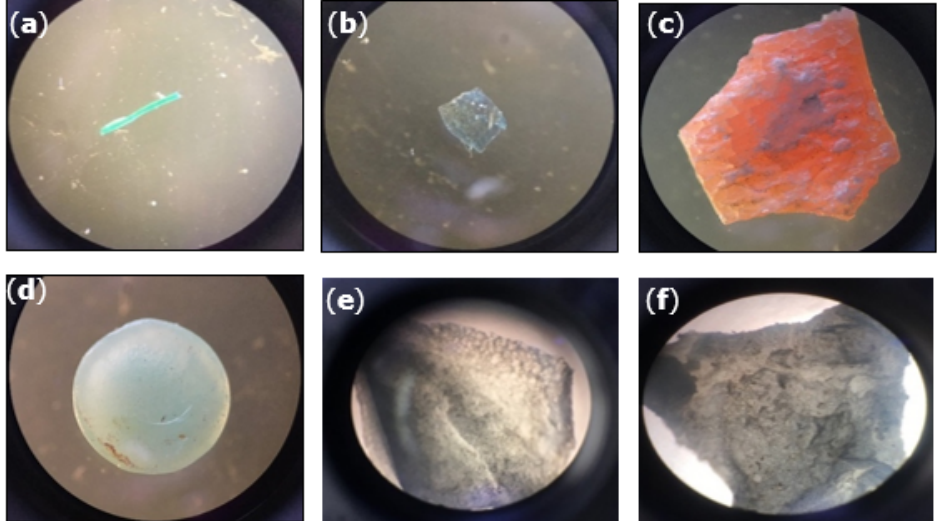
Figure 5. Microplastics (1–5 mm) viewed under stereo and compound microscope. ( a ) Strain of pol- polymer, ( b ) polyethylene fiber (50 × mag.), ( c ) cracked surface of polyethylene plastic (50 × mag.), ymer, ( b ) polyethylene fiber (50× mag.), ( c ) cracked surface of polyethylene plastic (50× mag.), ( d ) a ( d ) a cracked surface of polypropylene plastic (50 × mag.), ( e ) a polyethylene microbead plastic cracked surface of polypropylene plastic (50× mag.), ( e ) a polyethylene microbead plastic (50× mag.) and ( f ) degraded polystyrene Styrofoam (40× mag.). (50 × mag.) and ( f ) degraded polystyrene Styrofoam (40 ×